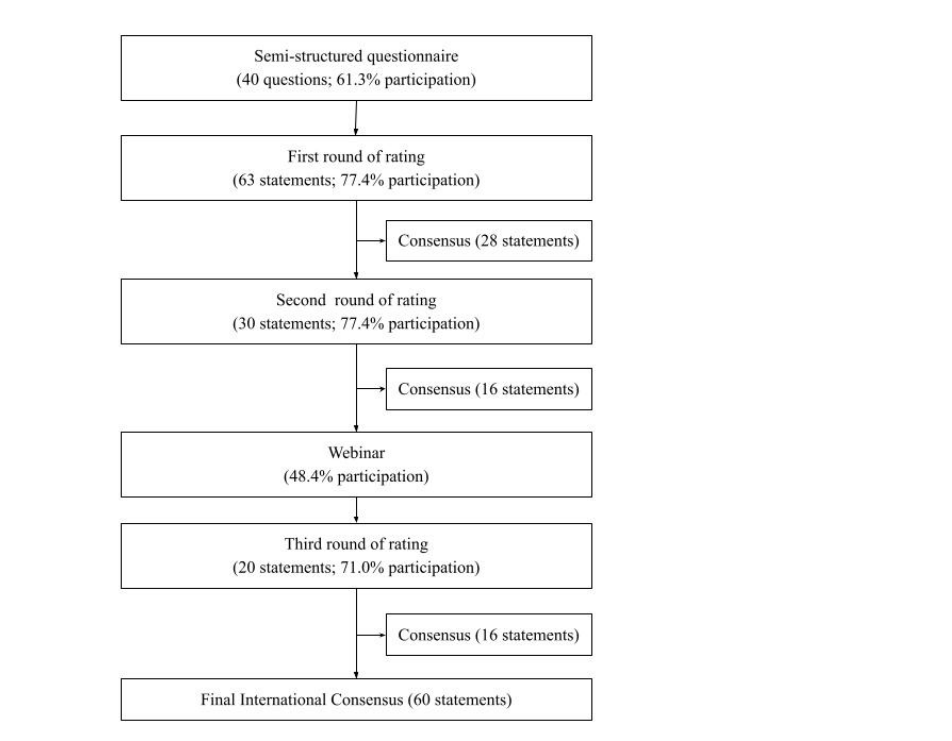
Figure 1. Flowchart of Delphi Process.